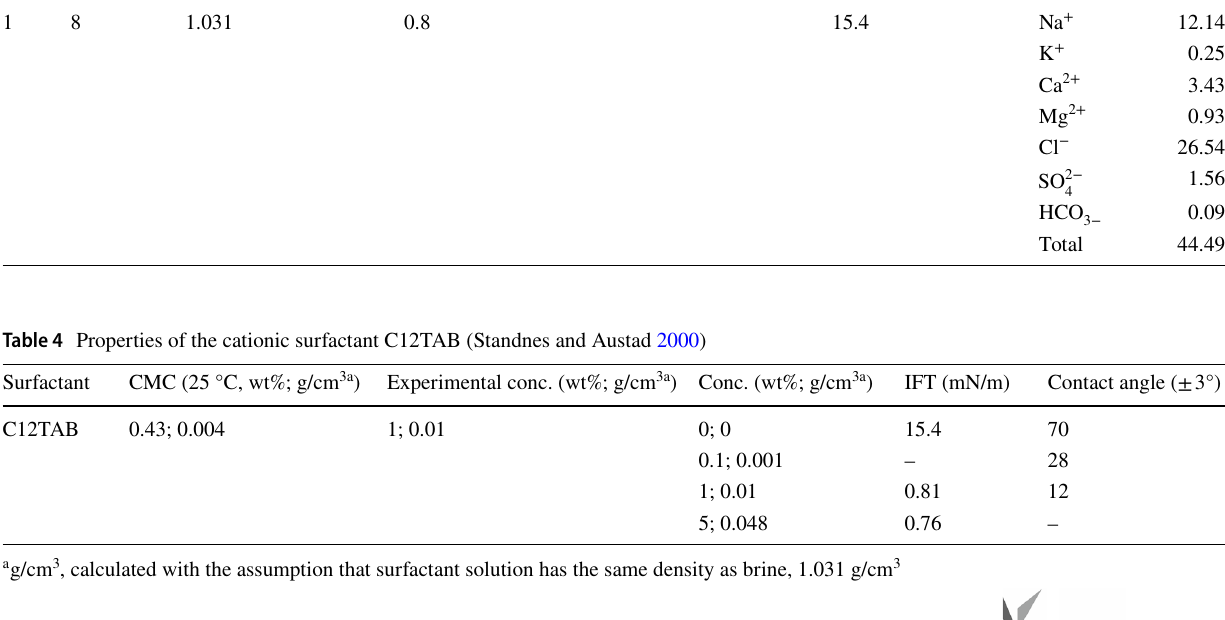
a g/cm 3 , calculated with the assumption that surfactant solution has the same density as brine, 1.031 g/cm 3